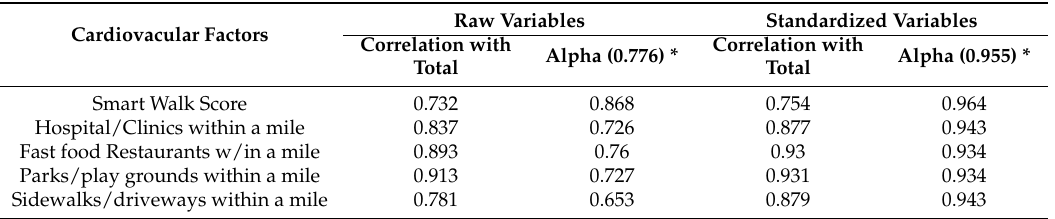
Table 1. Internal consistency for cardiovascular factors.